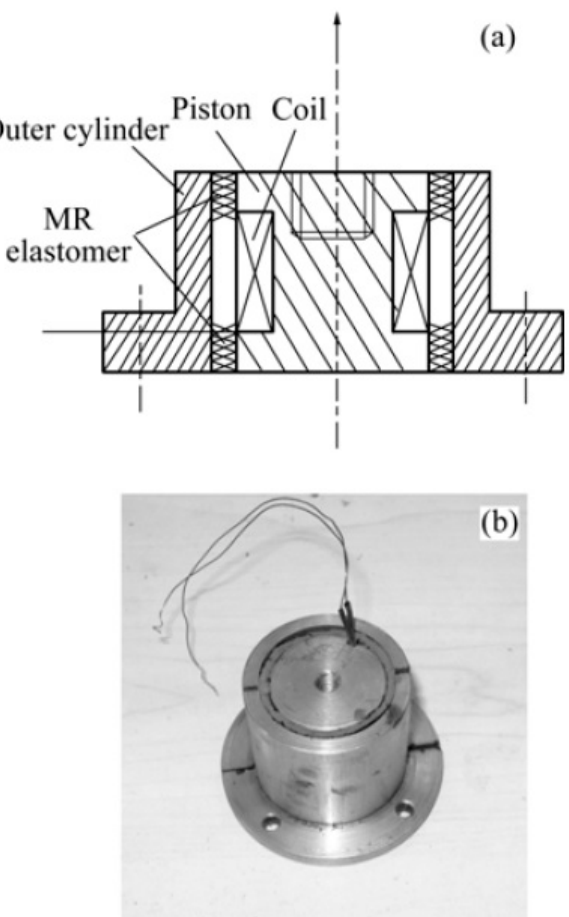
Figure 10. Schematic configuration ( a ) and photograph ( b ) of the MRE absorber. Reprinted from [28], © 2009 with permission from Elsevier.